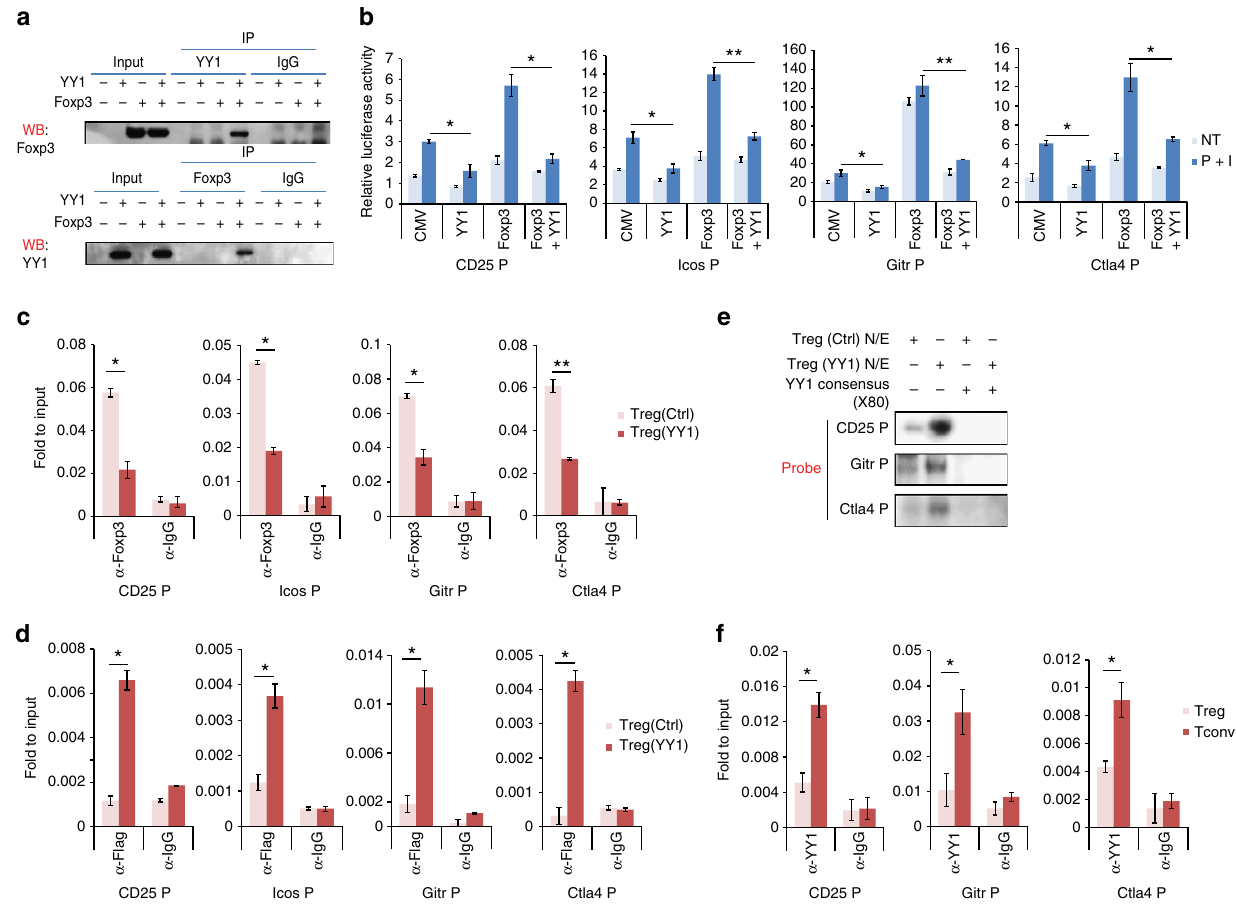
Figure 8 | YY1 inhibits expression of Foxp3-target genes. ( a ) HEK293Tcells were transfected with a Foxp3- or YY1- expression vector. Cell lysates were immunoprecipitated with an anti-Foxp3, anti-YY1 or control IgG antibody. Then, proteins were immunoblotted by an anti-Foxp3 or anti-YY1 antibody, as indicated. IP, immunoprecipitation; WB, immunoblot. ( b ) Transactivation activity of YY1 and Foxp3 on the Foxp3-target genes was measured by transient reporter assay. EL4 cells were transfected with CD25P-, IcosP-, GitrP- or Ctla4P-luciferase reporter construct in combination with Foxp3 or YY1 expression vector. ( c , d ) Binding of Foxp3 ( c ) and YY1-Flag ( d ) to the promoters of the Foxp3-target genes in control or YY1-Flag-expressing T reg cells was measured by ChIP assay. ( e ) Binding of YY1 to YY1-binding sites (YBS) in the promoters of the CD25 , Gitr and Clta4 genes was detected by EMSA using control or YY1-expressing T reg nuclear extracts. Competition assay was performed with YY1 consensus sequence (x80). ( f ) Binding of YY1 to the promoters of